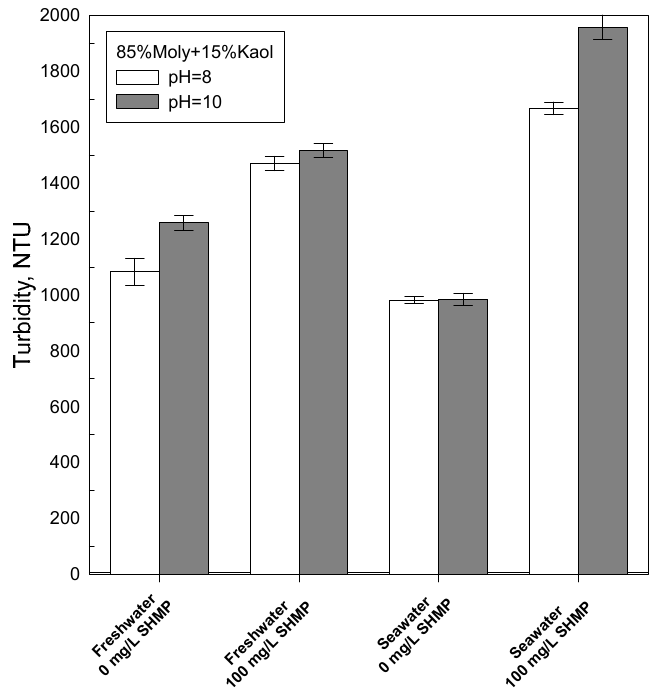
Figure 6. Turbidity results of suspensions of 85% molybdenite + 15% kaolinite at pH 8 and 10, in freshwater and seawater, with and without SHMP as a dispersant. Moly: molybdenite; kaol: kaolinite.